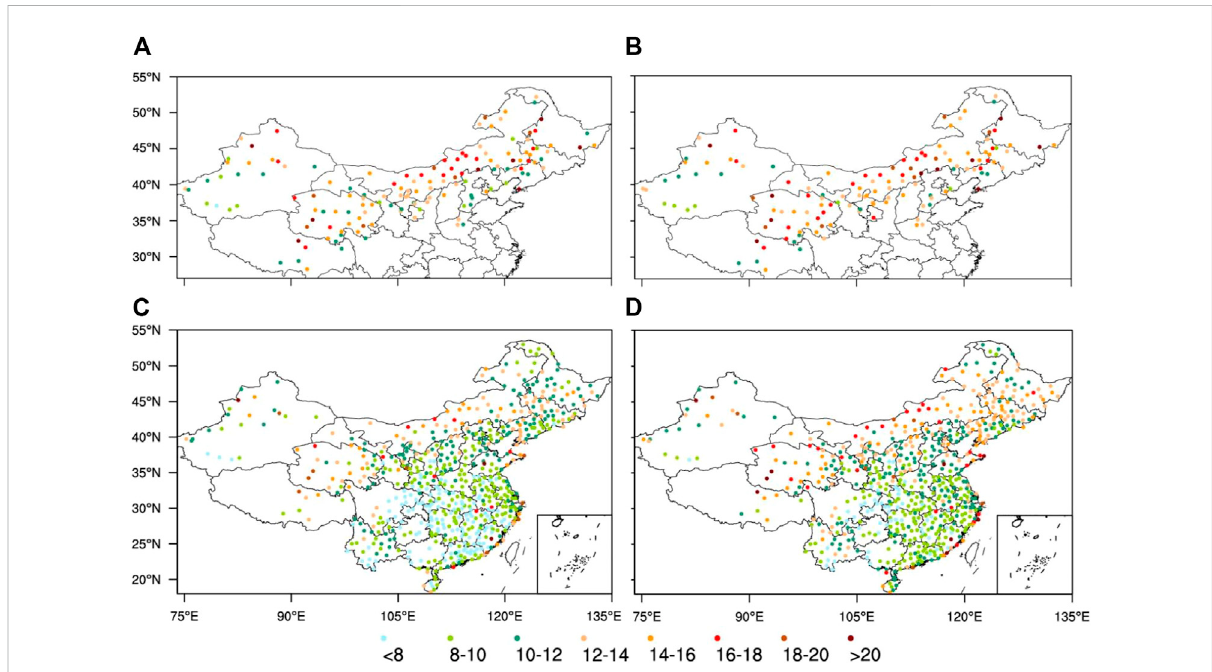
FIGURE 6 ThewindspeedofsandstormEW90 (A) andEW95 (B) extreme-windevents(accompaniedbylocal-sourcesandstorm)innortherChina,andthe wind speed of all the EW90 (C) and EW95 (D) extreme-wind events in China (regardless the accompanying of